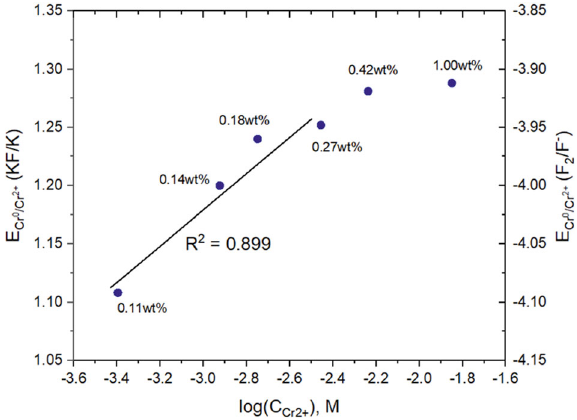
Fig. 3 The Nerst potentials associate with Cr 0 /Cr 2 + redox reaction at different calculated concentrations of Cr 2 + ions in FLiNaK at 600 °C. The left y -axis shows the potential relative to the pseudo KF/ K potential and the right y-axis shows that calculated potential referenced to the F 2 /F −